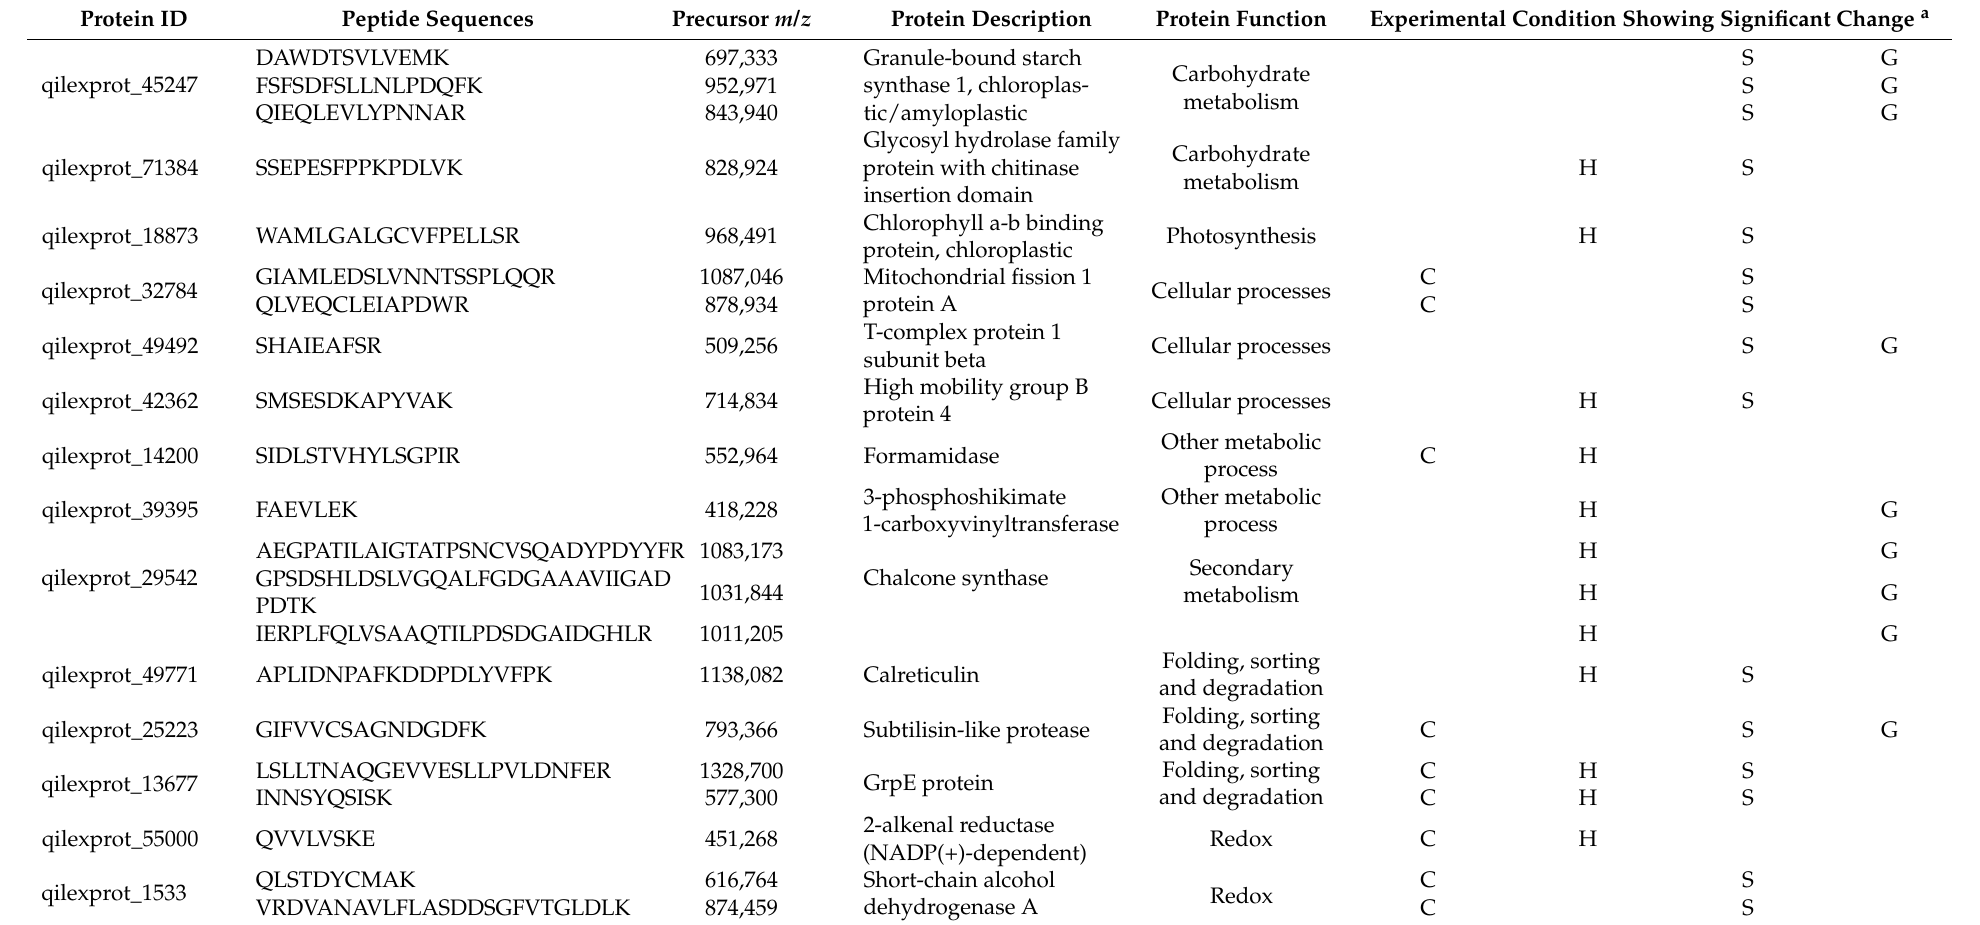
Table 1. List of peptides and proteins selected as putative markers of tolerance to